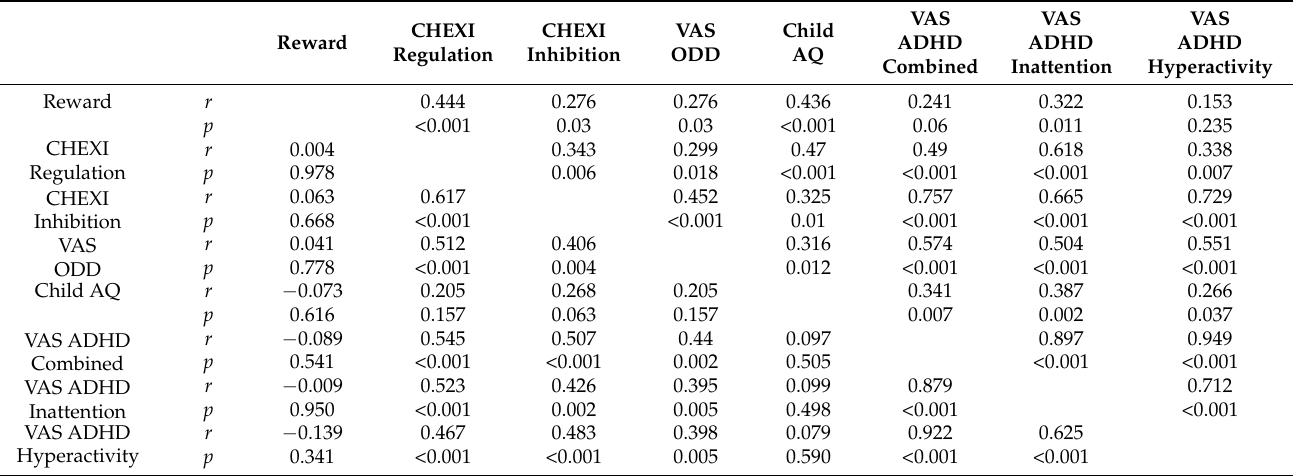
Table 2. Partial correlations controlling for age and gender between the traits and the reward system helpfulness.